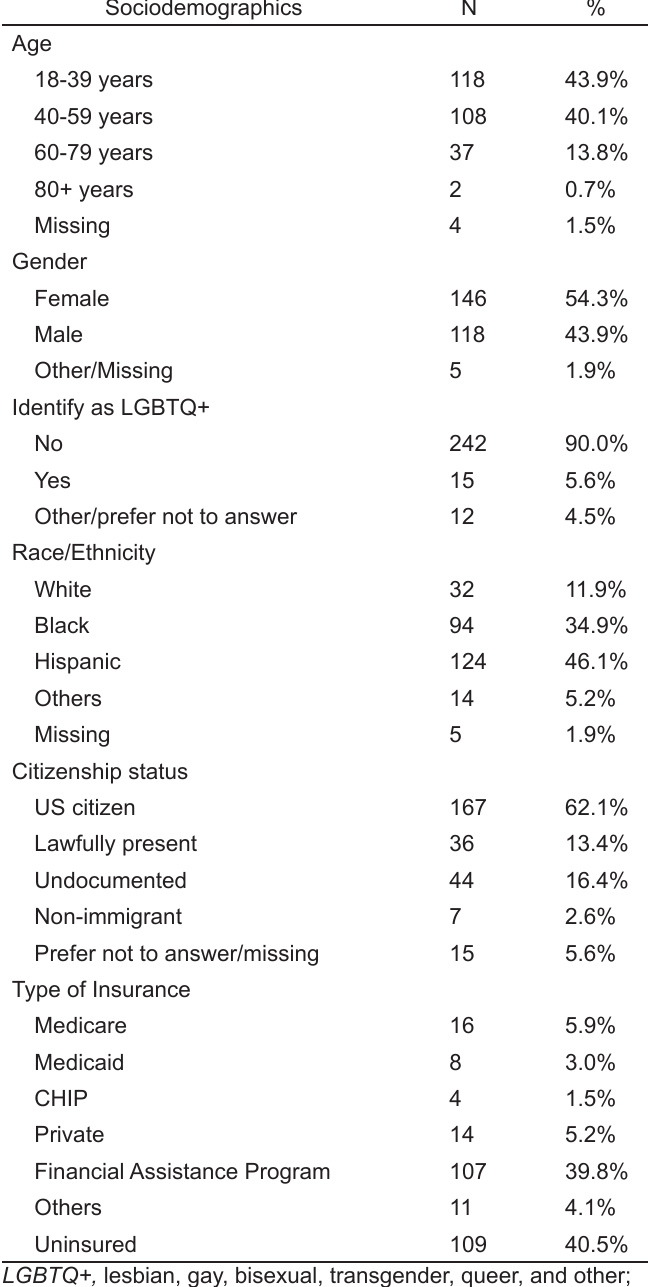
Table 1. Sociodemographic characteristics of patients